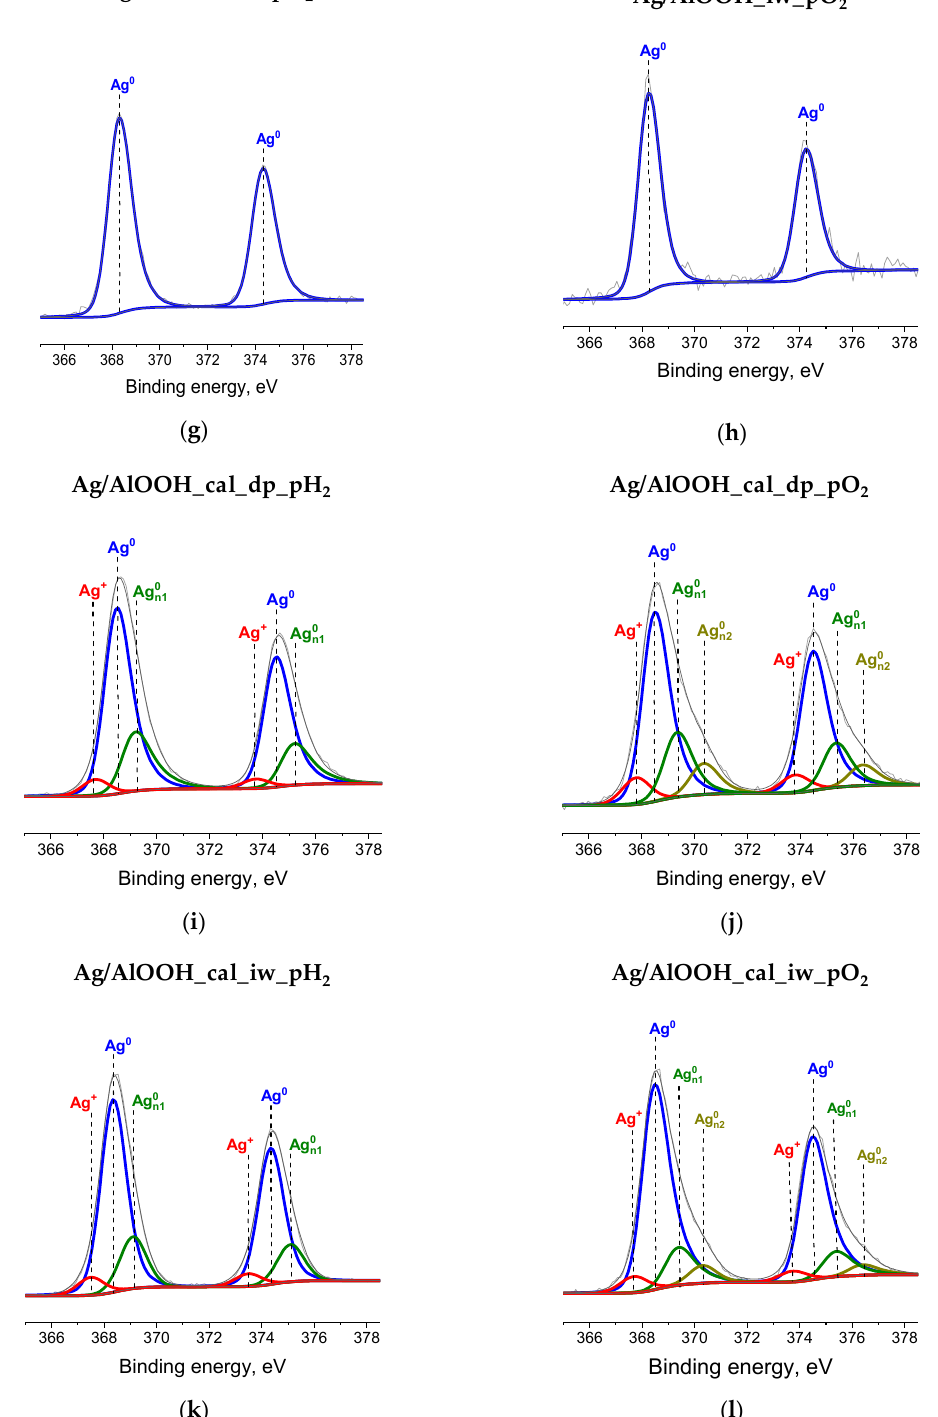
Figure 2. Ag 3d XPS spectra of studied catalysts: ( a ) Ag/ γ -Al 2 O 3 _dp_pH 2 ; ( b ) Ag/ γ -Al 2 O 3 _dp_pO 2 ; ( c ) Ag/ γ -Al 2 O 3 _iw_pH 2 ;